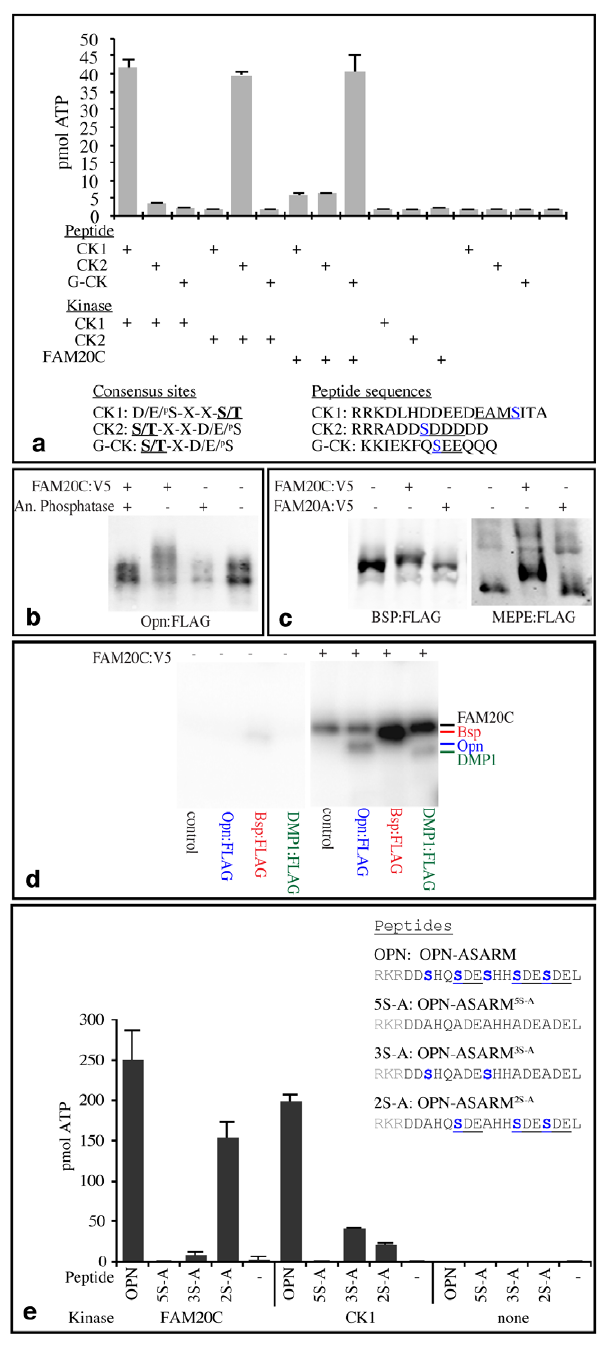
Figure 3. FAM20C phosphorylates SIBLING proteins. a) Activity of FAM20C on peptides reported to be uniquely recognized by